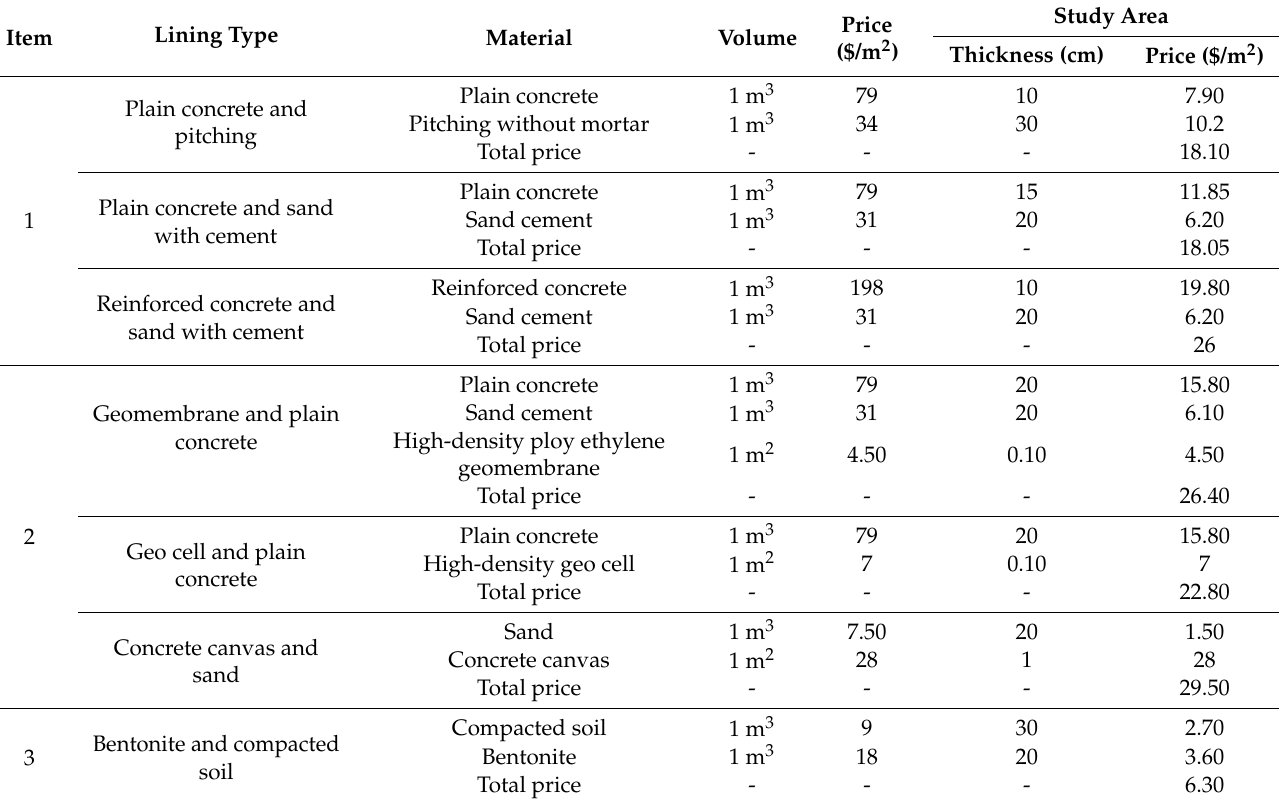
Table 2. Specifications, quantities, and prices of different lining